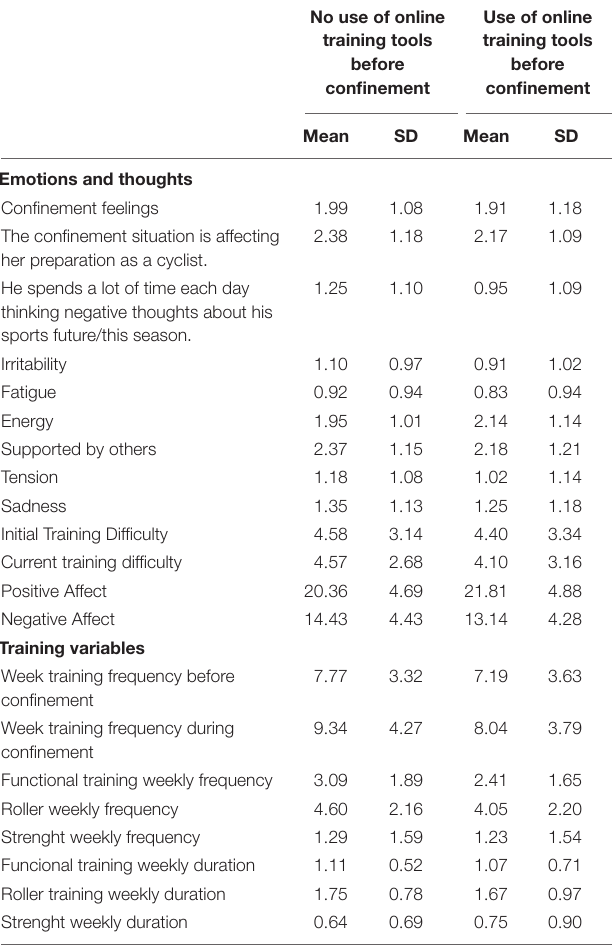
TABLE 1 | Mean and standard deviation (SD) of cyclists that employed (or not) online training tools before confinement.